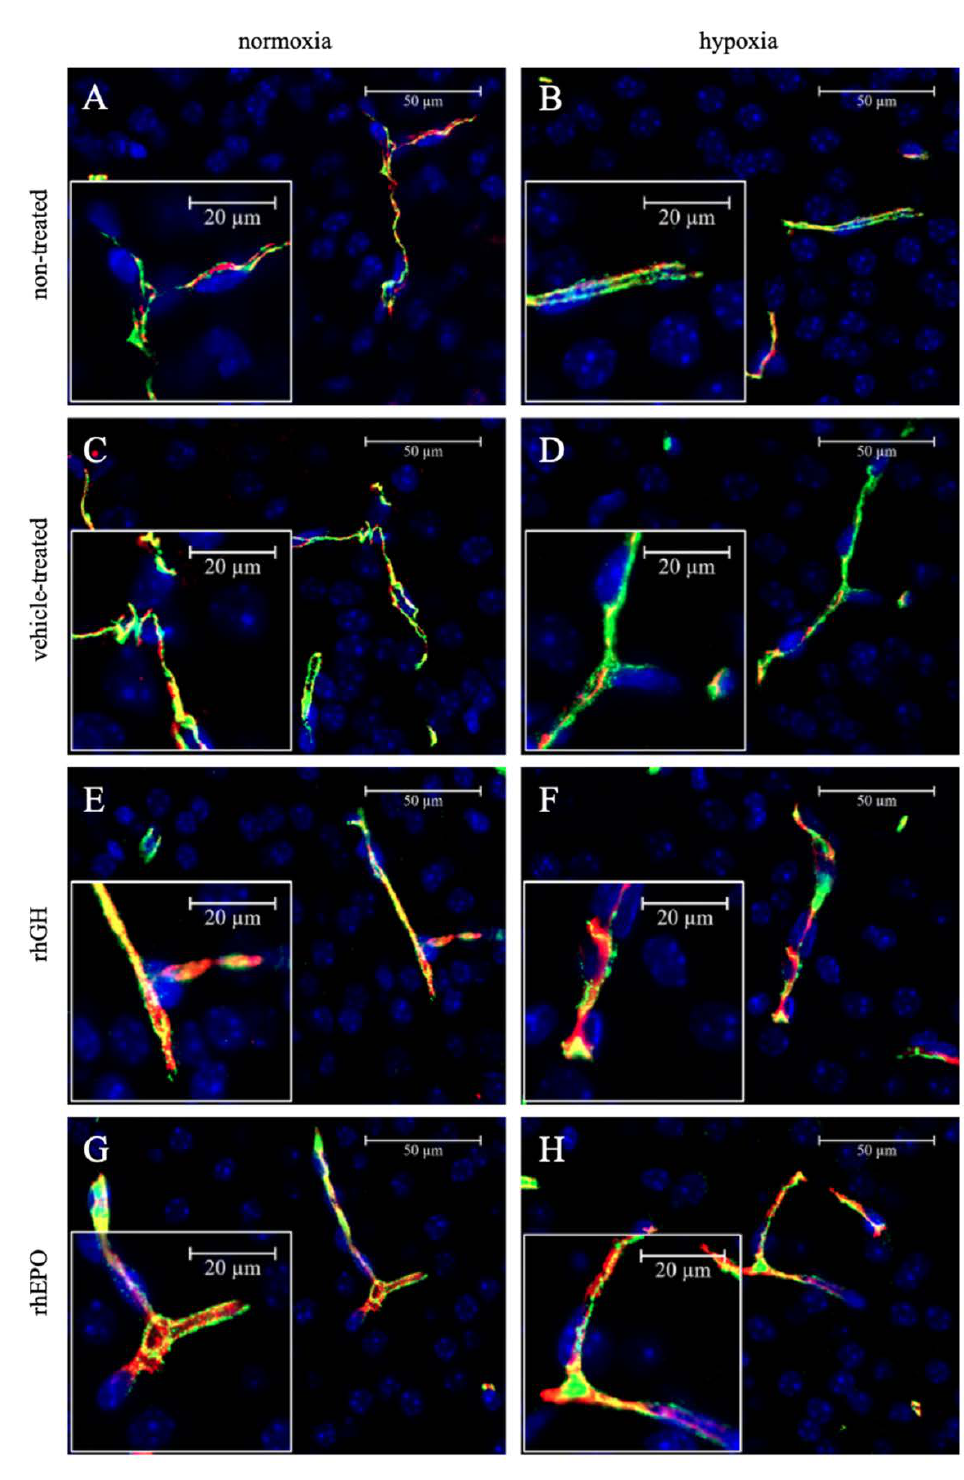
Figure 5. Representative photomicrographs of PECAM-1 (green) and OCLN (red) protein co-staining of vascular endothelial cells in hypoxic developing mouse brains ( B , D , F , H ) compared to normoxic controls ( A , C , E , F ) after a 48 h regeneration period in NT (A,B), VT ( C , D ), rhGH- ( E , F ), and rhEPO-treated brains ( G , H ) in the parietal cortex. Blue, 4 ′ ,6-diamidino-2-phenylindole (DAPI) nuclear counterstain.